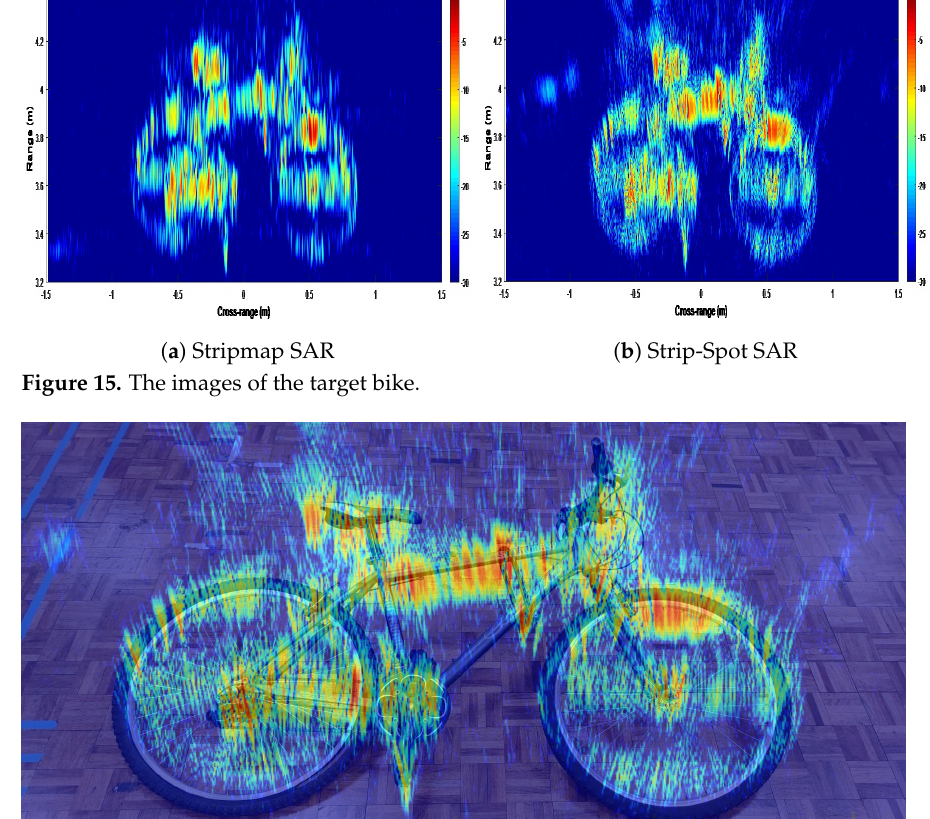
Figure 16. Comparison of the real bike and the result of overlapping the photo and the